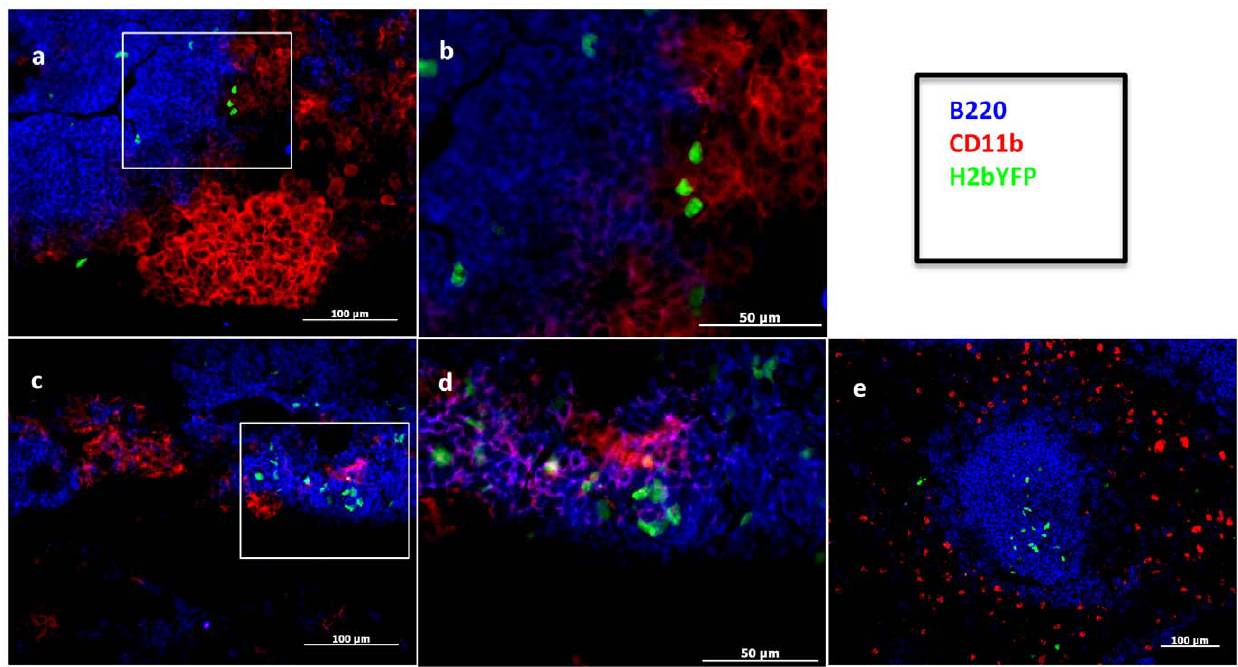
Figure 5. Visualization of YFP + cells in the omentum. Omenta from mice inoculated intraperitoneally (i.p.) with 1000 plaque forming units (pfu) virus in complete media (cDMEM) or cDMEM alone (mock) and harvested at day 9 (omentum) and day 12 (spleen). Omenta (A–D) and spleen (E) were cryosectioned and stained with the antibodies to detect YFP, CD11b or B220 as described in Materials and Methods. a) YFP + (virus-infected) cells within the B220 + area of omental immune aggregate; boxed area magnified in (b). c) CD11b + YFP + cells; boxed area magnified in (d). e) YFP + splenic B cell follicles with surrounding CD11b + extrafollicular region.